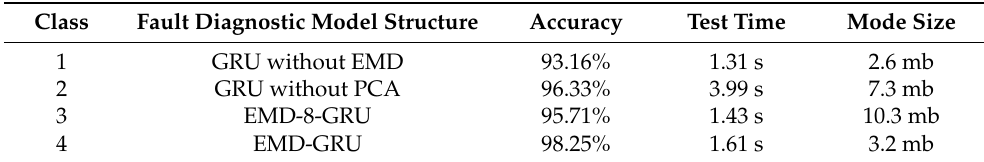
Table 7. The simulation results of different network